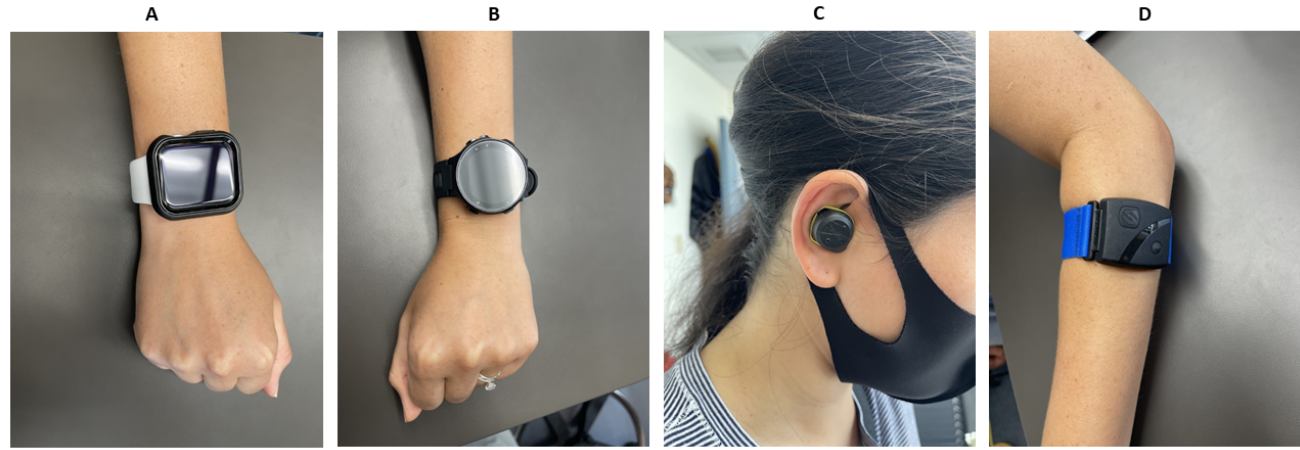
Figure 1. Placement of wearable heart rate monitors. ( A ) Apple Watch series 4, ( B ) Garmin Forerunner 735XT, ( C ) Jabra Elite earbuds, and ( D ) Scosche Rhythm 24 devices.